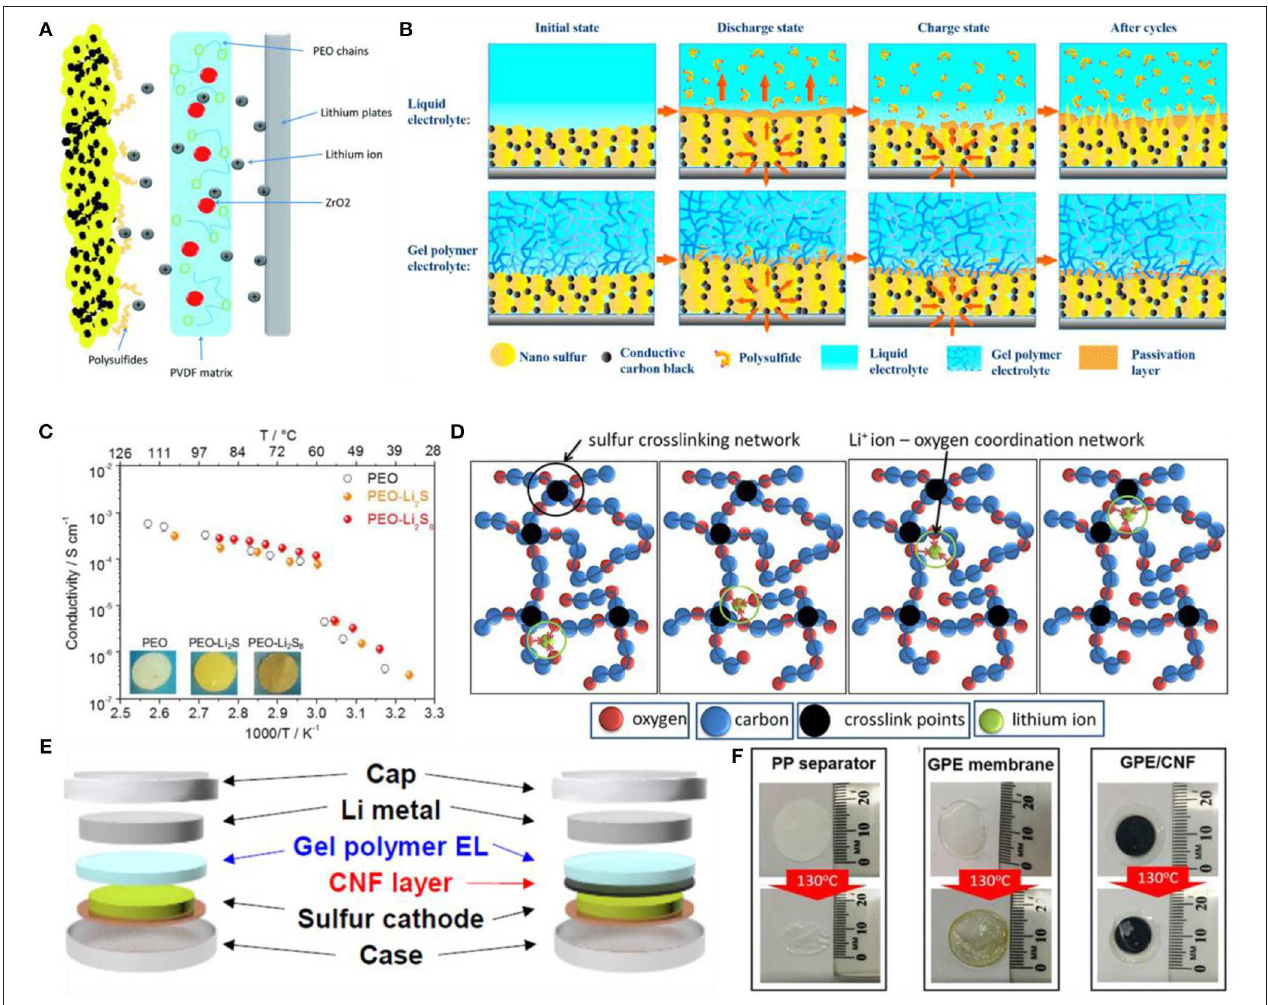
FIGURE 2 | Li-sulfur batteries based on gel polymer electrolyte (GPE). (A) The illustration of Li + ion transport and polysulfide blocking mechanism for the membrane of PPZr-GPE. Reproduced with permission ( Nair et al., 2016). Copyright 2017, Journal of Materials Chemistry A. (B) The immobilization mechanism for polysulfide. Reproduced with permission (Zhang et al., 2013). Copyright 2016, Nano Energy. (C) Temperature dependence of the ionic conductivity for PEO, PEO-Li 2 S and